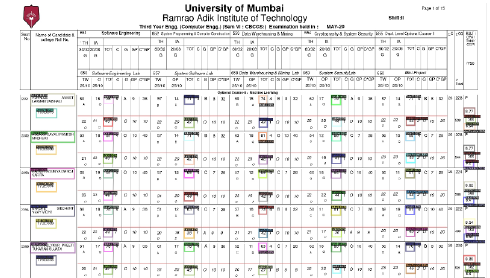
Figure 5. Detected Fields